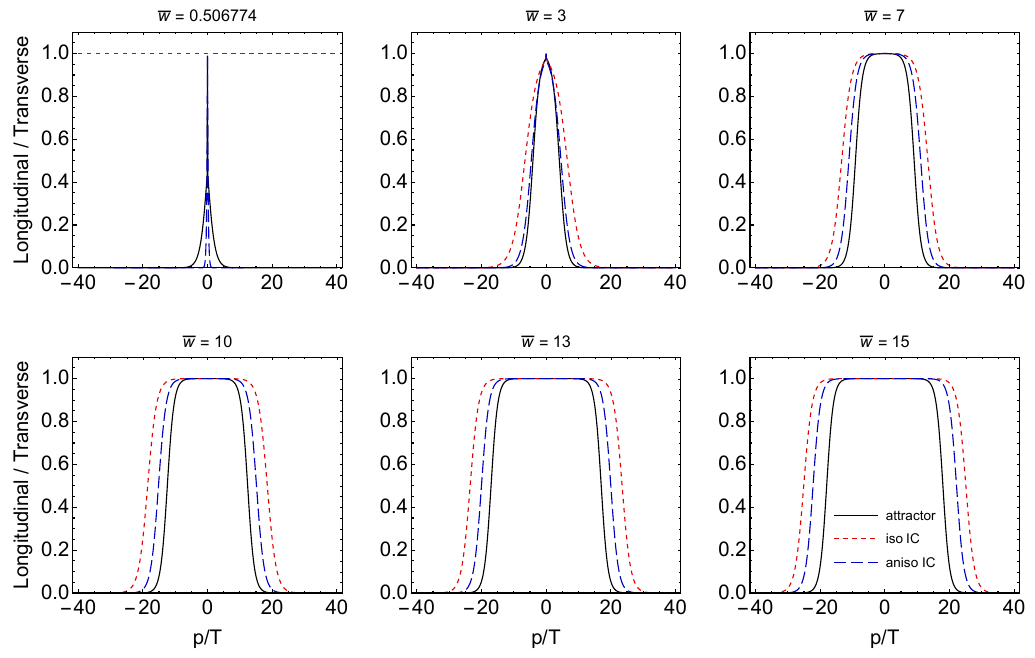
Figure 11 . Longitudinal to transverse ratio, f (0 ; 0 ; p ) =f ( p; 0 ; 0), as a function of p=T . The di(cid:11)erent panels correspond to di(cid:11)erent scaled times w and within each panel the ratio obtained from the attractor is shown as a solid line while the ratio obtained from typical isotropic and anisotropic initial conditions are plotted as red short-dashed and blue long-dashed lines, respectively.